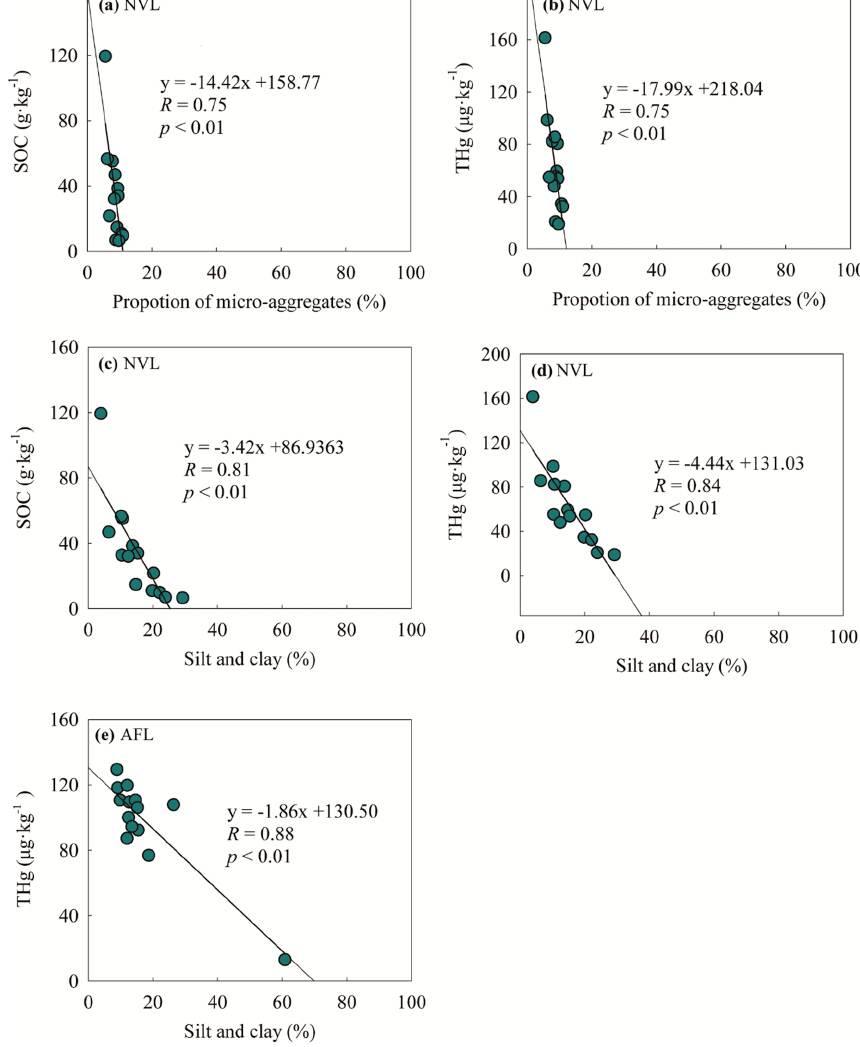
Figure A2. Line regression relationships between THg concentration, SOC concentration, the proportion of micro-aggregates, and proportion of silt and clay. NVL: native vegetation land; AFL: abandoned farmland.